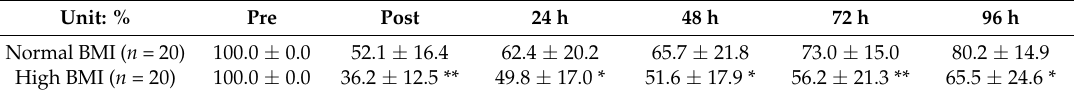
Table 2. Changes in the maximum strength according to the body mass index after eccentric exercise. Unit: %